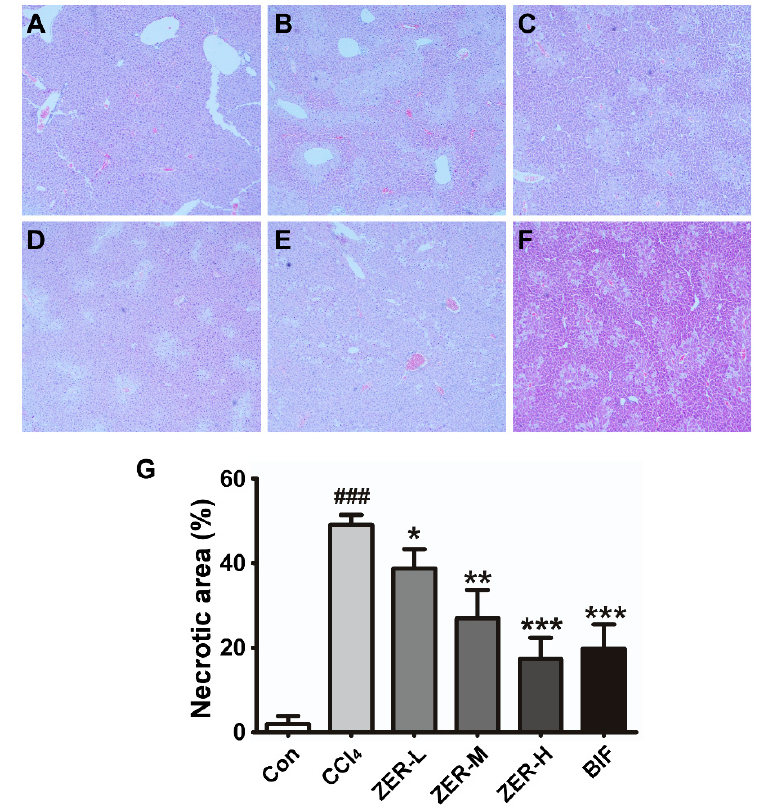
Figure 2. Protective effects of ZER on liver histopathology in CCl 4 -induced ALI mice. Liver tissues were stained with Hematoxylin and Eosin (H&E) staining (40 × ). ( A ), control group; ( B ), CCl 4 group; ( C ), ZER-L group; ( D ), ZER-M group; ( E ), ZER-H group; ( F ), Bifendate (BIF) group. The pale pink areas are the necrotic areas. ( G ) Quantification of liver necrosis in histological sections ( n = 10). Values represent the mean ± SD. ### p < 0.001 compared with the control group; * p < 0.05, ** p < 0.01, and *** p < 0.001 compared with the CCl 4 -treated group.